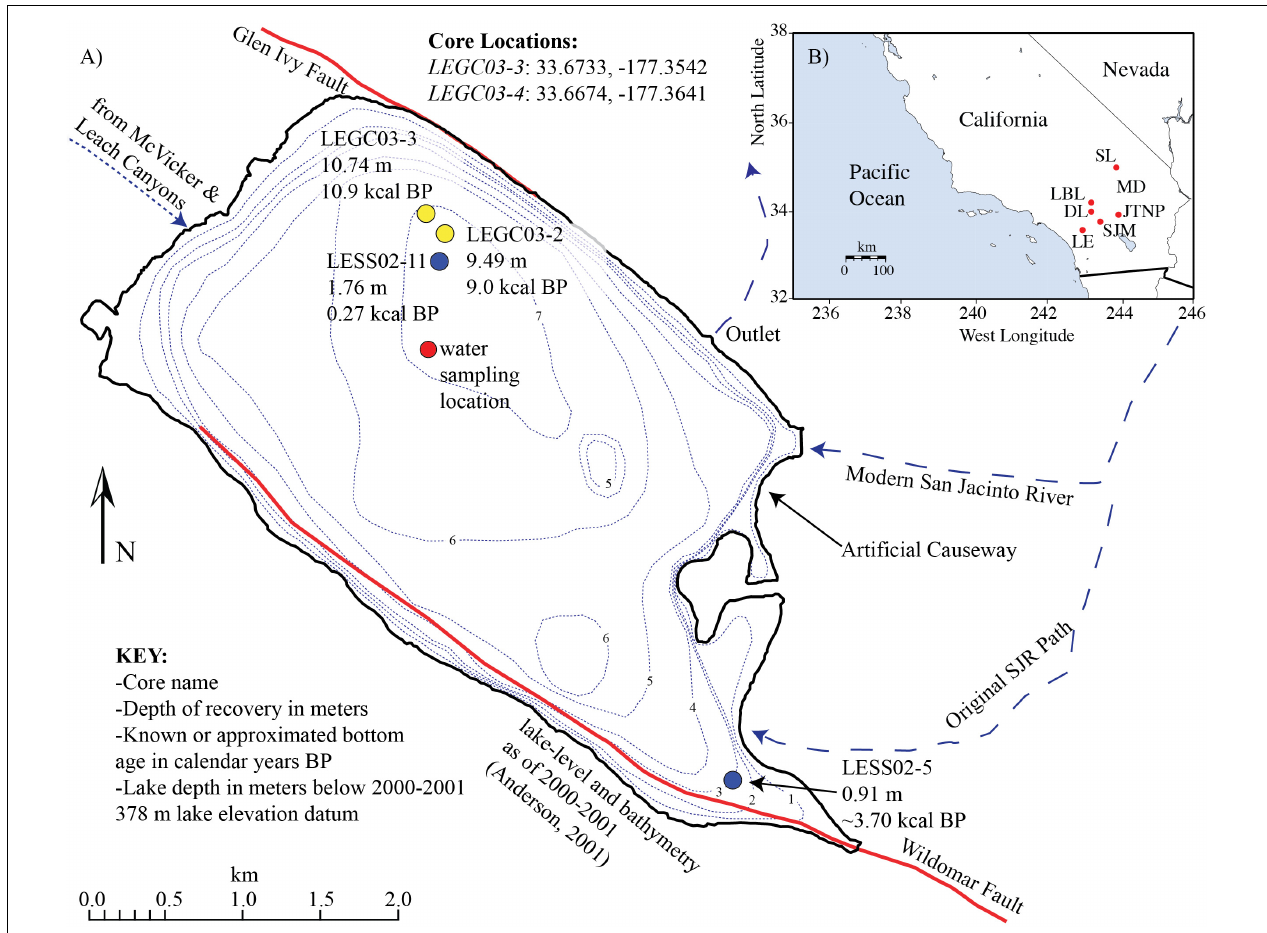
FIGURE 1 | (A) Location map with core and water sampling sites shown. (B) Inset map with relevant sites labeled. LE, Lake Elsinore; MD, Mojave Desert; LBL, Lower Bear Lake; DL, Dry Lake; SJM, San Jacinto Mountains; JTNP, Joshua Tree National Park; SL, Silver